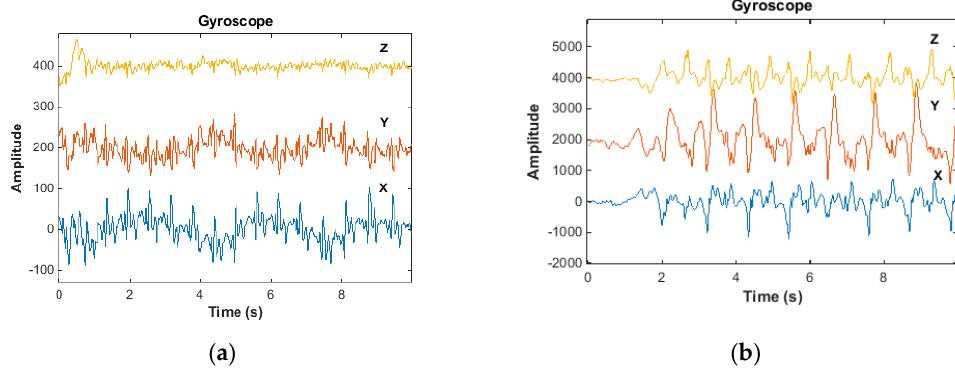
Figure 19. Signals recorded by the hybrid textile electrode: ( a ) Sit; ( b ) walk.